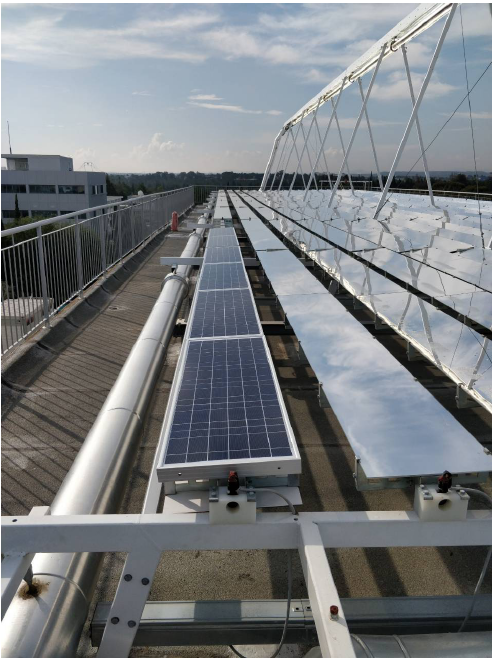
Figure 2. PV arrays on one